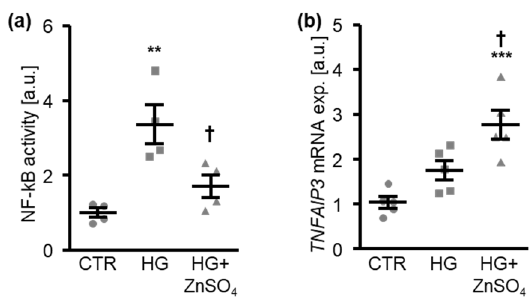
Figure 4. Zinc sulfate suppresses NF-kB activation induced by high levels of glucose in HAoSMCs. ( a ). Normalized NF-kB-dependent transcriptional activity ( n = 4; arbitrary units, a.u.) in HAoSMCs treated for 30 min with control (CTR) or high glucose levels (HG) in the absence and presence of ZnSO 4 . ( b ). Relative mRNA expression of TNFAIP3 ( n = 5; a.u.) in HAoSMCs treated for 24 h with control (CTR) or high glucose levels (HG) in the absence and presence of ZnSO 4 . ** ( p < 0.01), *** ( p < 0.001) significant difference versus control group; † ( p < 0.05) significant difference versus HG-treated group.